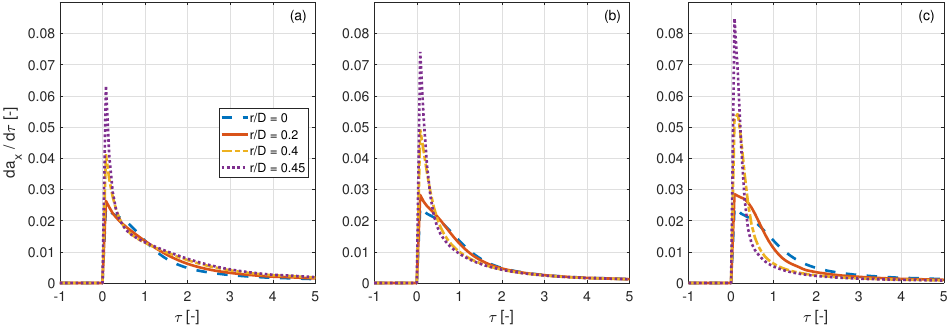
Figure 10. Time derivative of a x at radial position from CFD model when base C T = 0.6, step ∆ C T = +0.1, ( a ) downwind part: θ az = 0 deg, ( b ) center part: θ az = 90 deg, ( c ) upwind part: θ az = 180 deg.